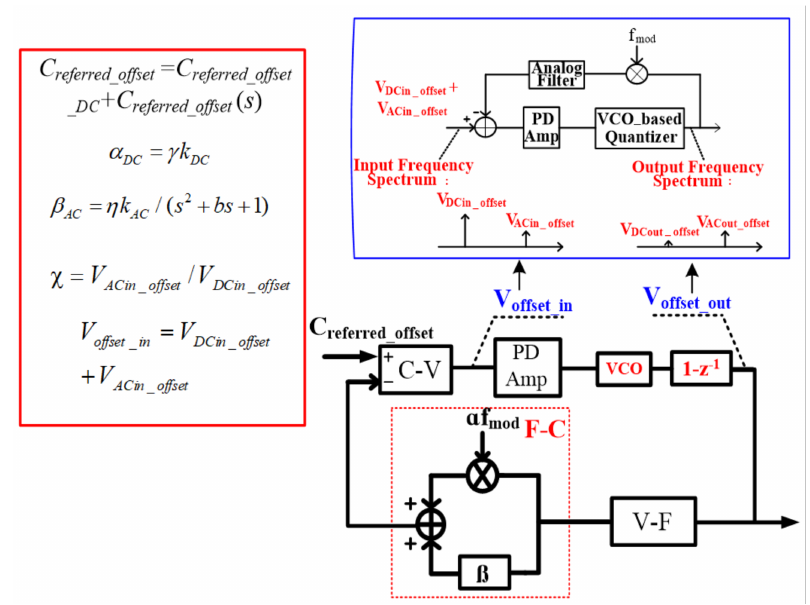
Figure 5. Principle of the offset minimization loop.